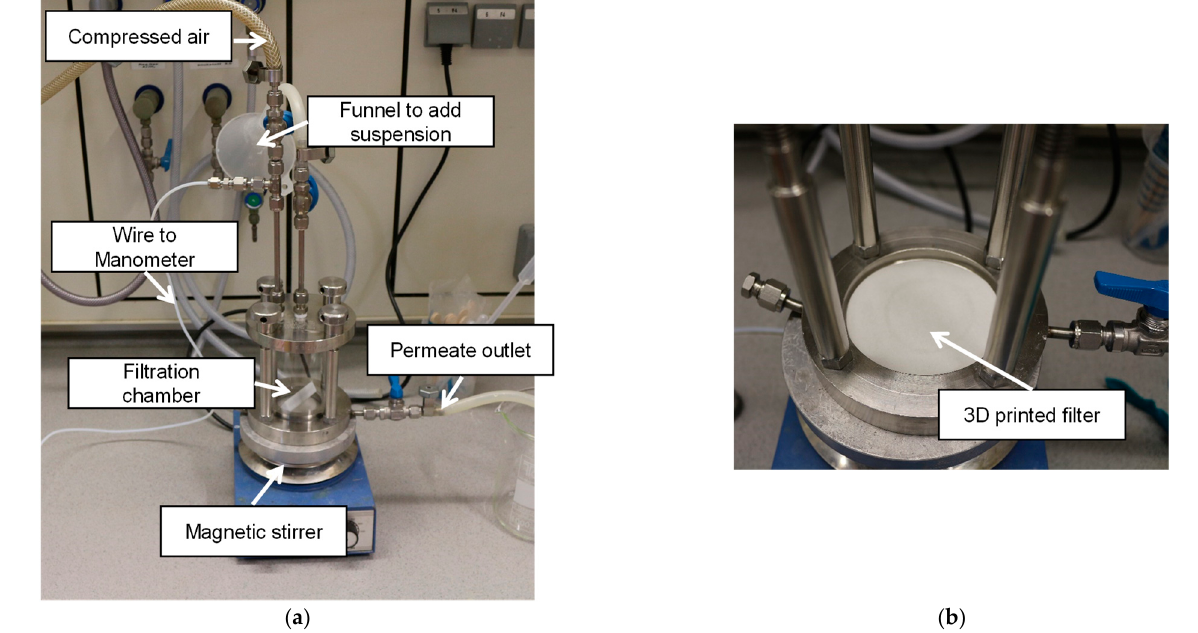
Figure 2. Self-build filtration set-up, for pressures up to 0.5 bar. ( a ) Set up with external utilities, ( b ) image of 3D printed filter placed inside the setup.